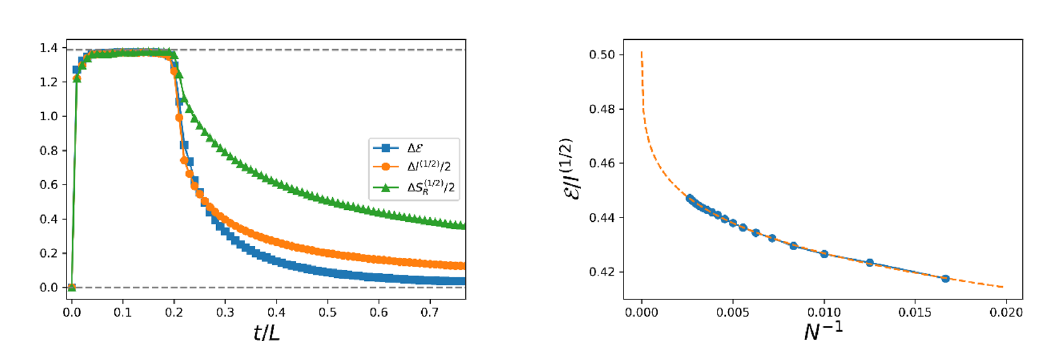
Figure 4 . Comparison between negativity, mutual information, and reflected entropy in free fermion systems after a local excitation by the fermion parity operator ( − 1) F is inserted at the interface between two adjacent intervals. Left: ∆ E (blue) ∆ I (1 / 2) / 2 (orange) ∆ S (1 / 2) N = 750 , l 1 = l 2 = N/ 5 . The dotted line is at 2 log 2 . Right: l 1 = l 2 = N/ 5 , t f = 3 N/ 10 . fit: aN − b + c with a = − 0 . 216( − 0 . 2202 , − 0 . 2118) , b = 0 . 1901(0 . 1342 , 0 . 246) , c = 0 . 5168(0 . 4925 , 0 . 541) . The value of c is consistent with (1.7). Similar finite-size effect deviations between E and I (1 / 2) / 2 were found after a global quench in ref.